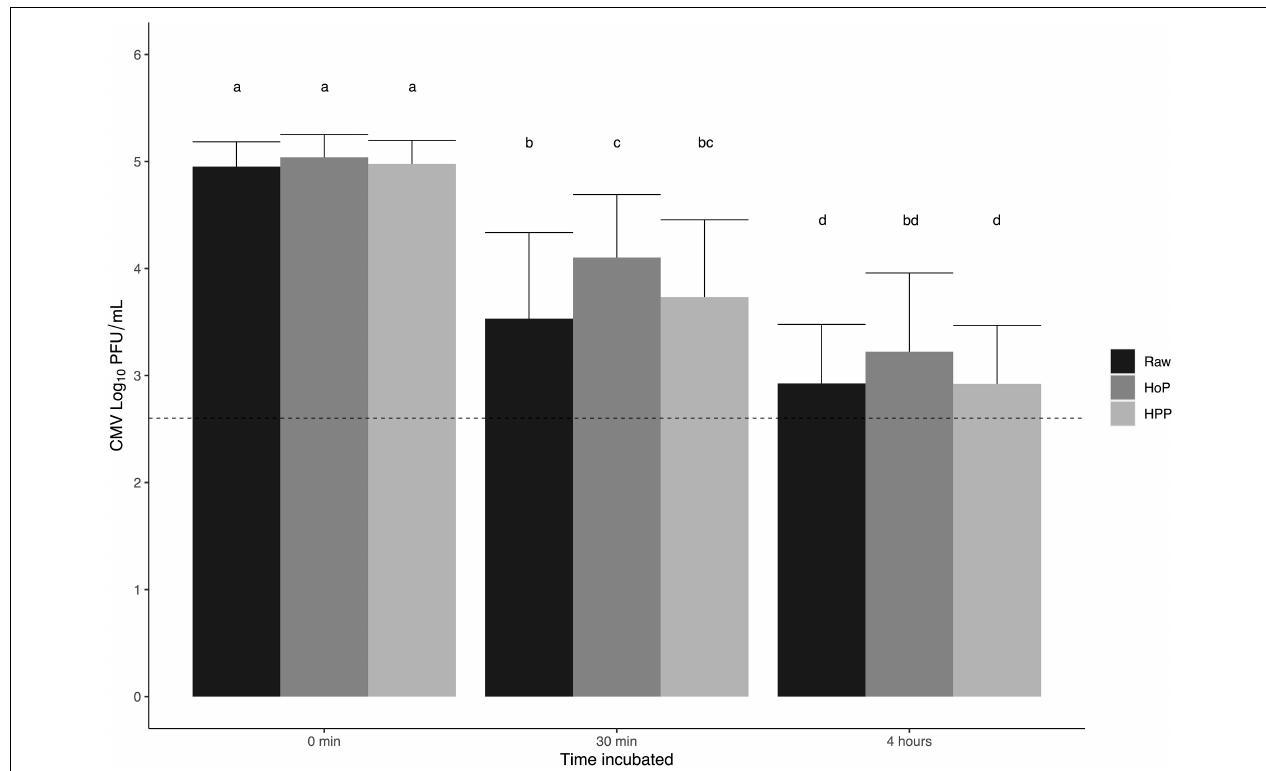
FIGURE 2 | Recovered titers of CMV from inoculated milk following incubation at room temperature. Mean CMV log PFU/mL for raw, Holder pasteurization (HoP), and high-pressure processing (HPP) treated pools. Each bar represents the mean of the pools plated in duplicate after 0 min, 30 min, and 4 h incubations (room temperature, ∼ 22 ◦ C) with error bars representing the standard deviation; dashed line represents the limit of detection. Statistical analyses were conducted using linear mixed effect models with post hoc pairwise comparisons. Different letters denote statistical significance ( P < 0.05).